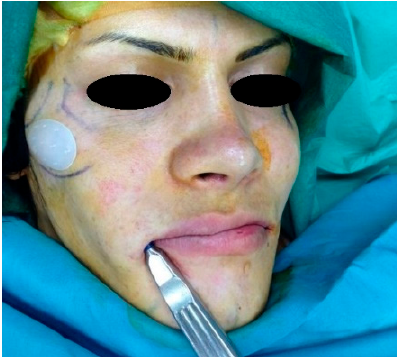
Figure 1. Once the implant pocket is harvested, the selected implant is located over the skin, above the pocket. Two paramedian points over the implant, about 1 cm from each other, are identified and marked, passing a 2/0 straight needle up to the underlining skin in order to mark both the implant and the